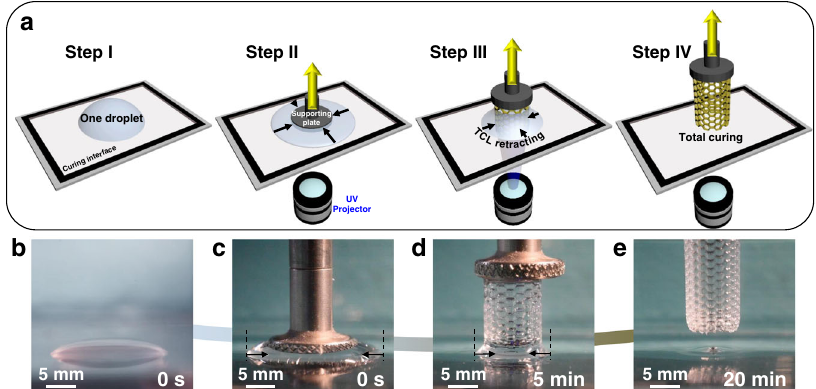
Fig. 1 Typical schematic and optical images of the one-droplet 3D printing process. a Scheme of the curing of a single droplet into the desired 3D structure. b – e Sequences of optical images of the UV curing-induced TCL receding process for the formation of designed 3D structures from a single droplet. With the continuous projection of the UV illumination pattern and the elevation of the supporting plate, the liquid resin is successively cured into solid structures at the curing interface. Simultaneously, the TCL of the resin droplet recedes with the consumption of the liquid resin. Finally, the liquid droplet is cured into a desired